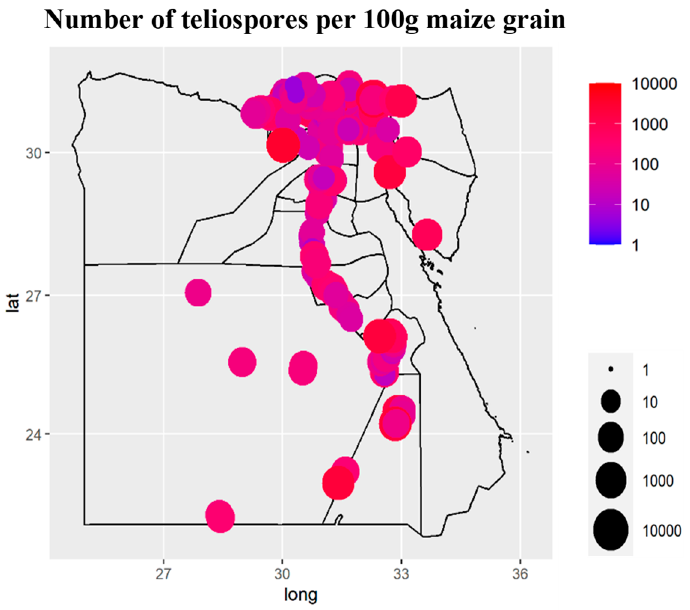
Figure 7. Geographical distribution and density (number of teliospores per 100 g grain) of common smut fungus ( Ustilago maydis ) in maize grain samples collected from the 25 maize-cropping governorates in Egypt. Circles in yellow indicate no occurrence of the pathogen.